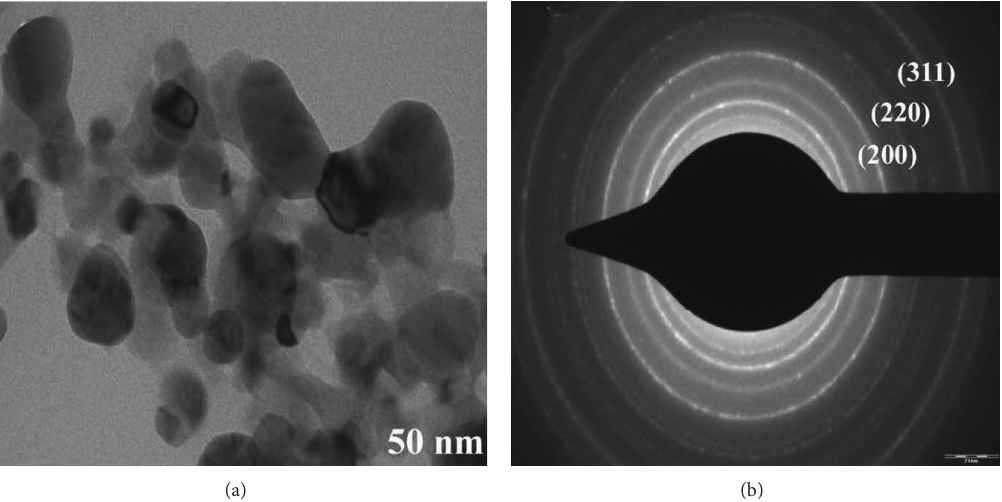
Figure 6: TEM image of silver nanoparticles shows spherical shape at 50 nm scale bar; (b) SAED pattern indicates crystalline nature of synthesized silver